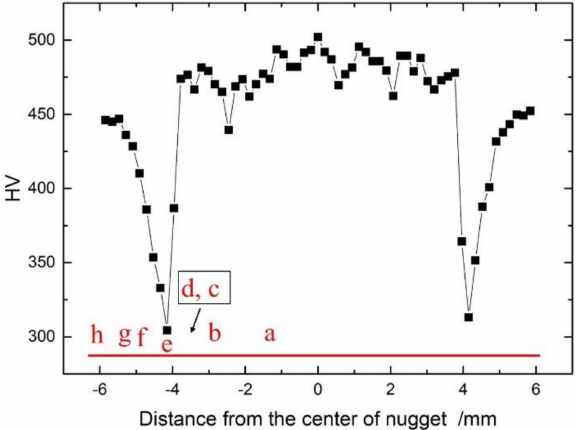
Figure 7. Microhardness measurement results on the typical spot welded joint in Figure 5; ( a )–( h ) correspond to the micro areas in Figure